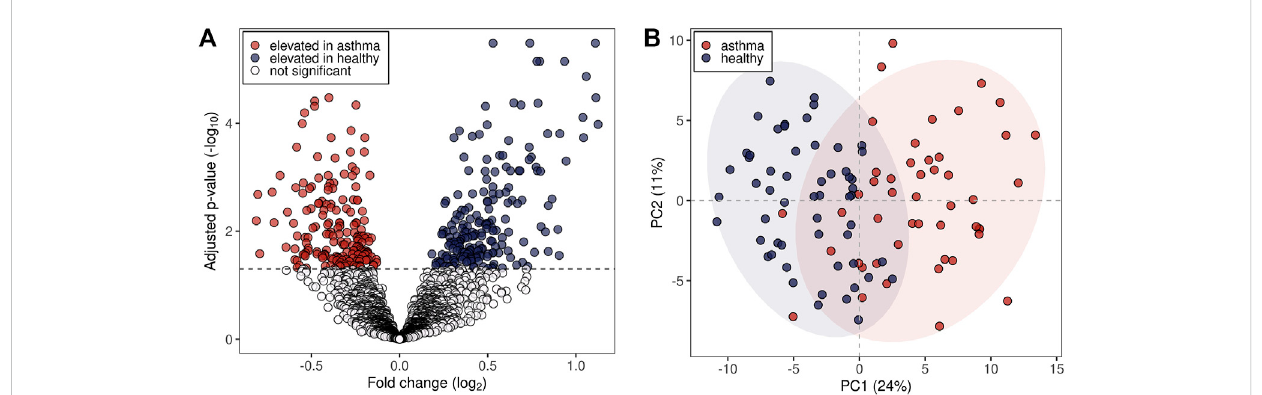
FIGURE 1 Statisticalanalysisof m/z featuresinbreathpro fi les. (A) Volcanoplotrepresentingalldetected2,315 m/z features.Dashedline:Benjamini-Hochberg adjusted p -value of 0.05. (B) First two principal components (PCs) score plot of the 134 putatively identi fi ed m/z features. Blue dots represent healthy probands and red dots asthmatic patients. 95% data ellipses were added per group for visual